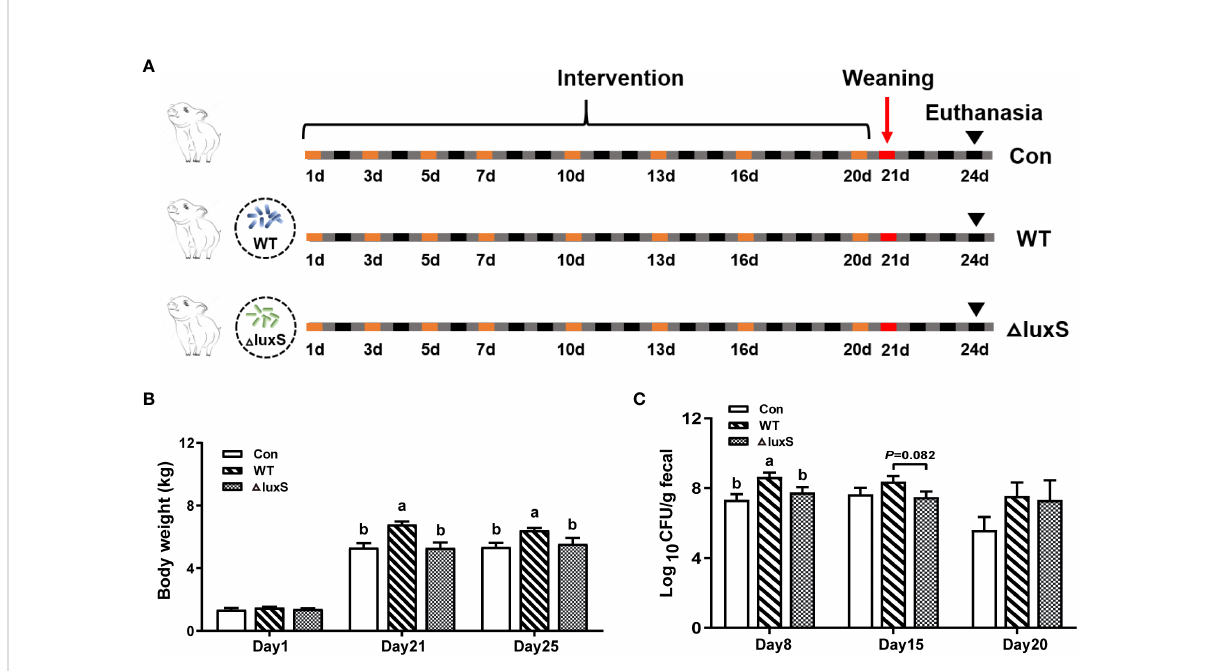
FIGURE 1 Design of piglet experiments and bacterial colonization in feces. (A) Experiment design and work fl ow. Piglets were randomly divided to 3 groups (6 piglets/group). The WT and D luxS groups were orally inoculated with 2 mL of LGG wild strain (WT) and luxS mutant strain ( D luxS), respectively, for 3 weeks (equivalent to 10 9 CFU/mL, shown as orange box) before weaning on day 21 (red box). Slaughter sampling was performed 3 days after weaning (black arrows). Con group was orally inoculated with PBS. (B) The body weights of piglets. (C) The colonization of Lactobacillus in feces at different time points. Feces were collected on days 8, 15 and 20 for bacterial counts. Statistical signi fi cance performed using one-way analysis of variance for multiple comparisons. Mean values not sharing common letters are signi fi cantly different ( P <0.05). Values are shown as mean ± SEM,